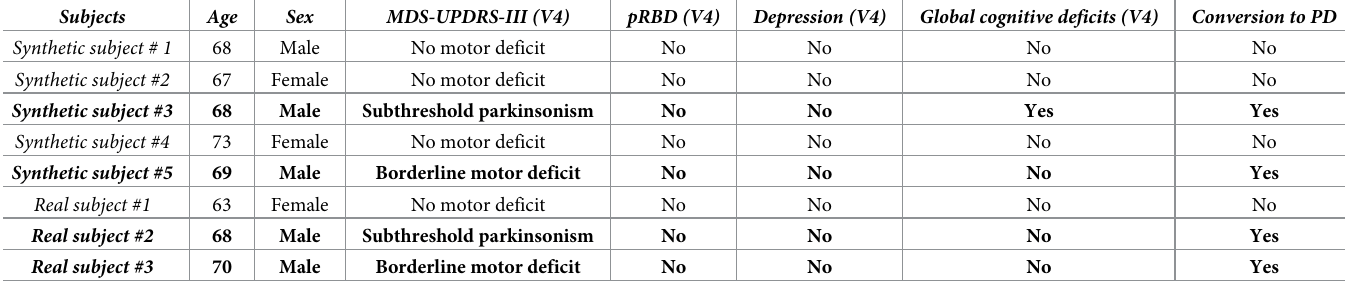
Table 4. Real and synthetic marker